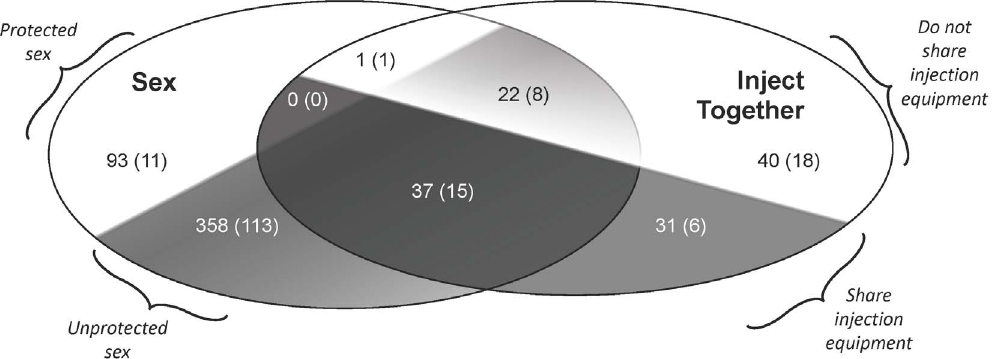
Figure 3. Risk relationships in the expansive and sociometric networks. Number of sexual and injection relationships in the expansive network, with numbers in parentheses indicating the subset of relationships present in the sociometric network (i.e. confirmed ties). Relationships indicated in the shaded portions of the figure (e.g., unprotected sex and equipment sharing) comprise the expansive and sociometric pre-vaccination networks.